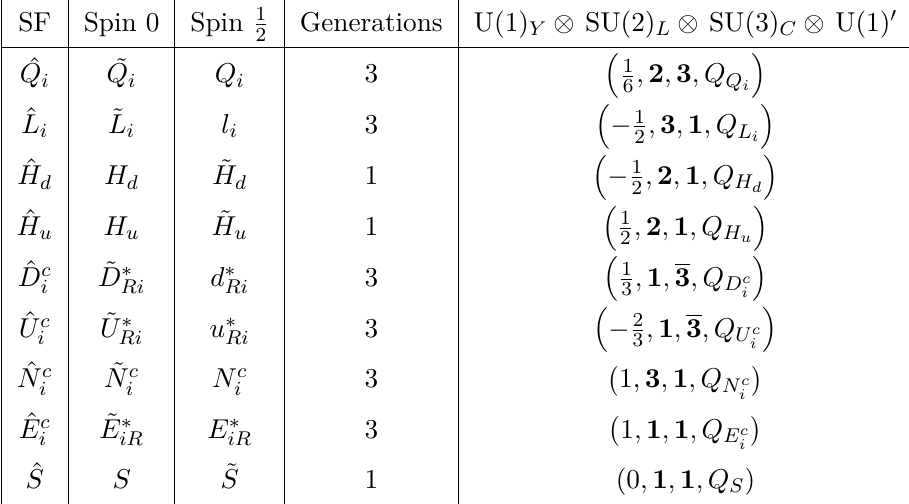
Table 1 . Superfield configuration in the non-universal U(1) 0